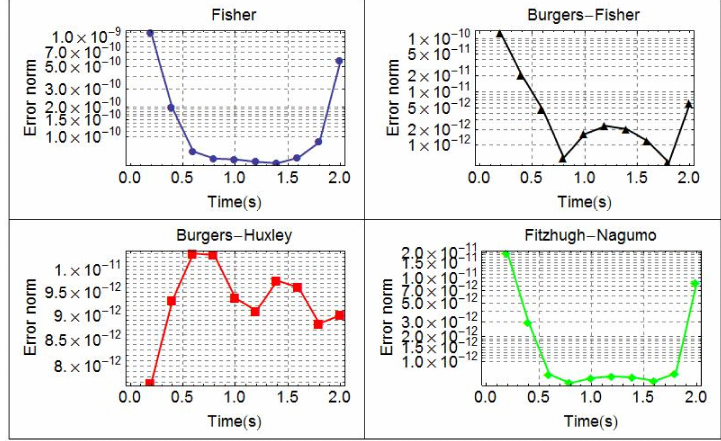
Fig. 5. Error norms at different time levels for the Fishers, Burgers-Fisher, Burgers-Huxley and the Fitzhugh-Nagumo equations